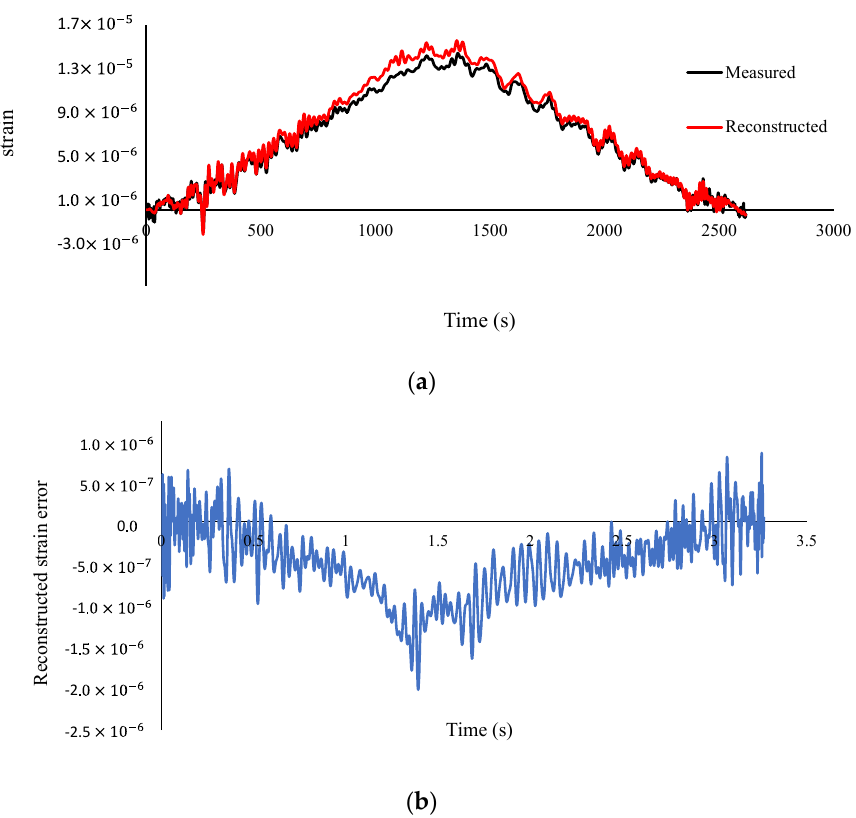
Figure 17. ( a ) Measured and reconstructed strain at mid-span ( b ) Error of reconstructed strain (Damage case 1—speed 0.94 m/s—sampling frequency 800 Hz).